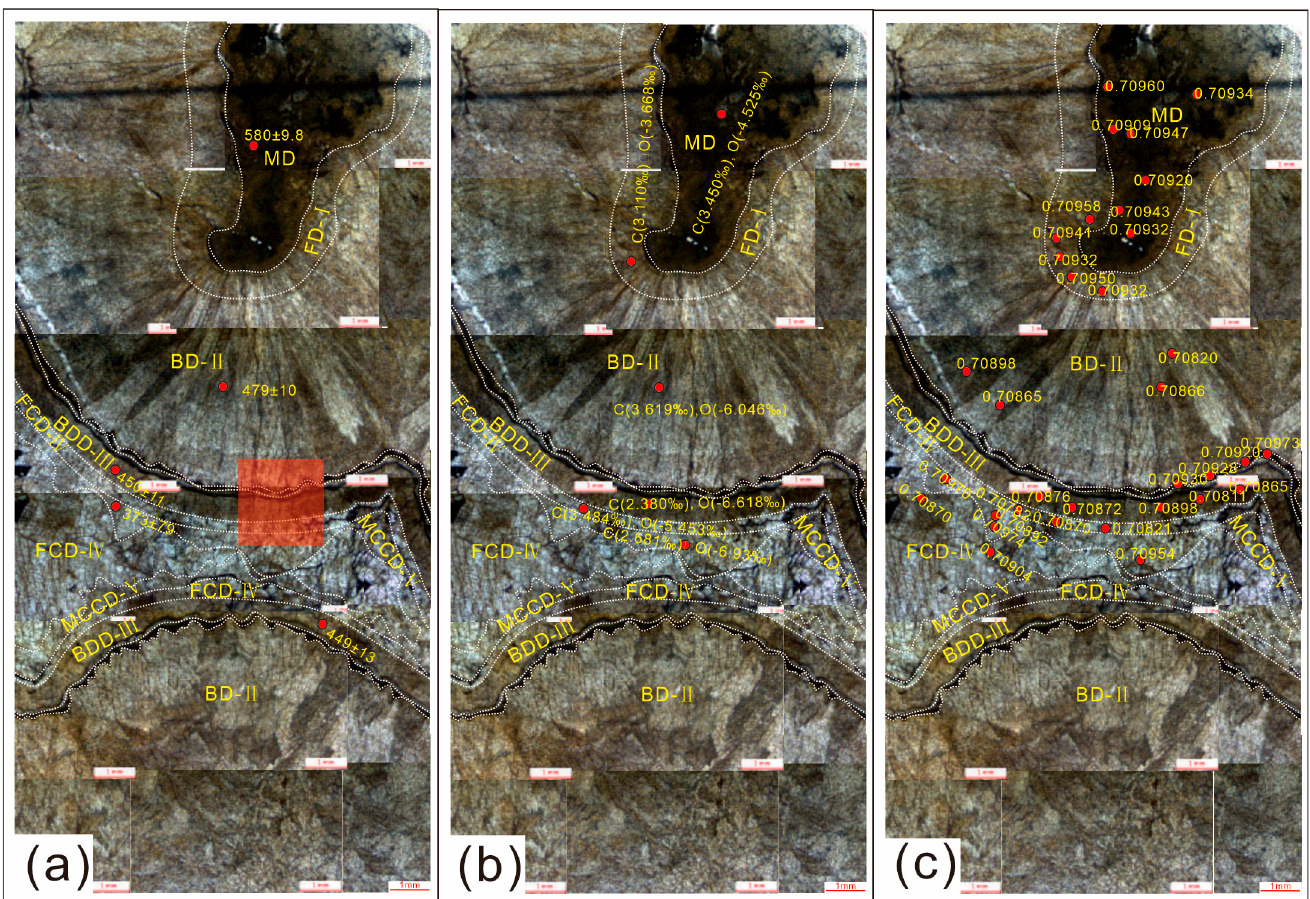
Figure 5. Photographs showing the results of in situ laser ablation U-Pb dating ( a ), carbon and oxygen isotopes ( b ), and 87 Sr/ 86 Sr ( c ) on the different fabric of Botryoidal dolomite. Please note that the red square in ( a ) highlights the area for which elemental mapping area was completed.